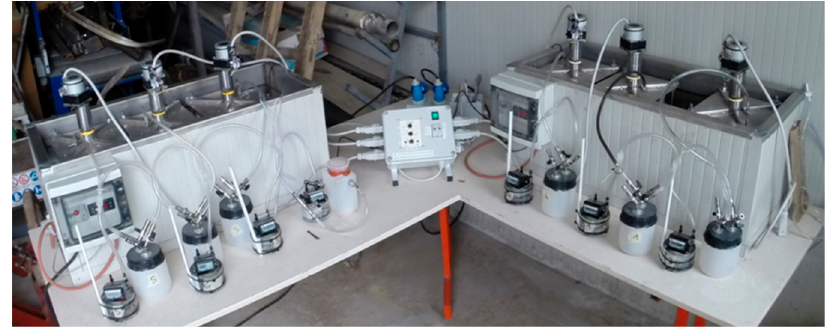
Figure 2. Detail of the experimental anaerobic digestion system.